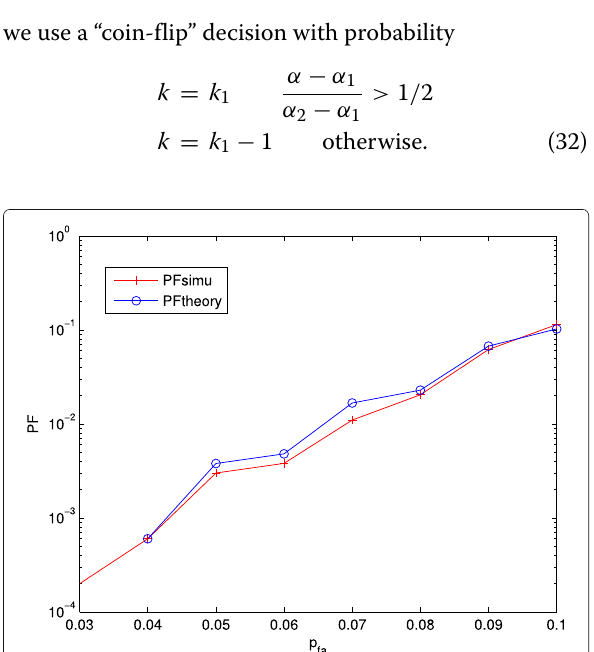
Fig. 3 Probability of detection for MA versus M x . Here, we have N (cid:2) = 27, b = 5, σ 2 = 1, σ w 2 = 4, k = 6, p fa = 0.05, and f ov = 5. Simulations are based on 5000